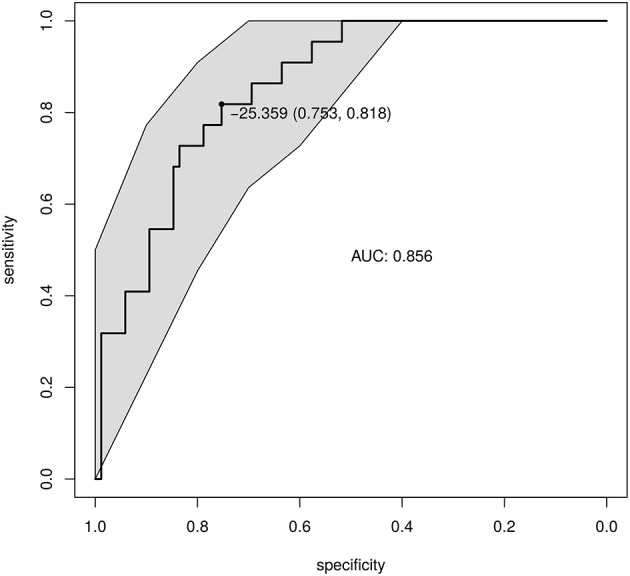
Diagnosis of CHB based on the GDI. The GDI was calculated based on the differential and prevalent OTUs. The ROC of the GDI produced by leave-one-out cross-validation is shown. The point shows the GDI threshold chosen based on Youden's J statistic, and the corresponding specificity and sensitivity.